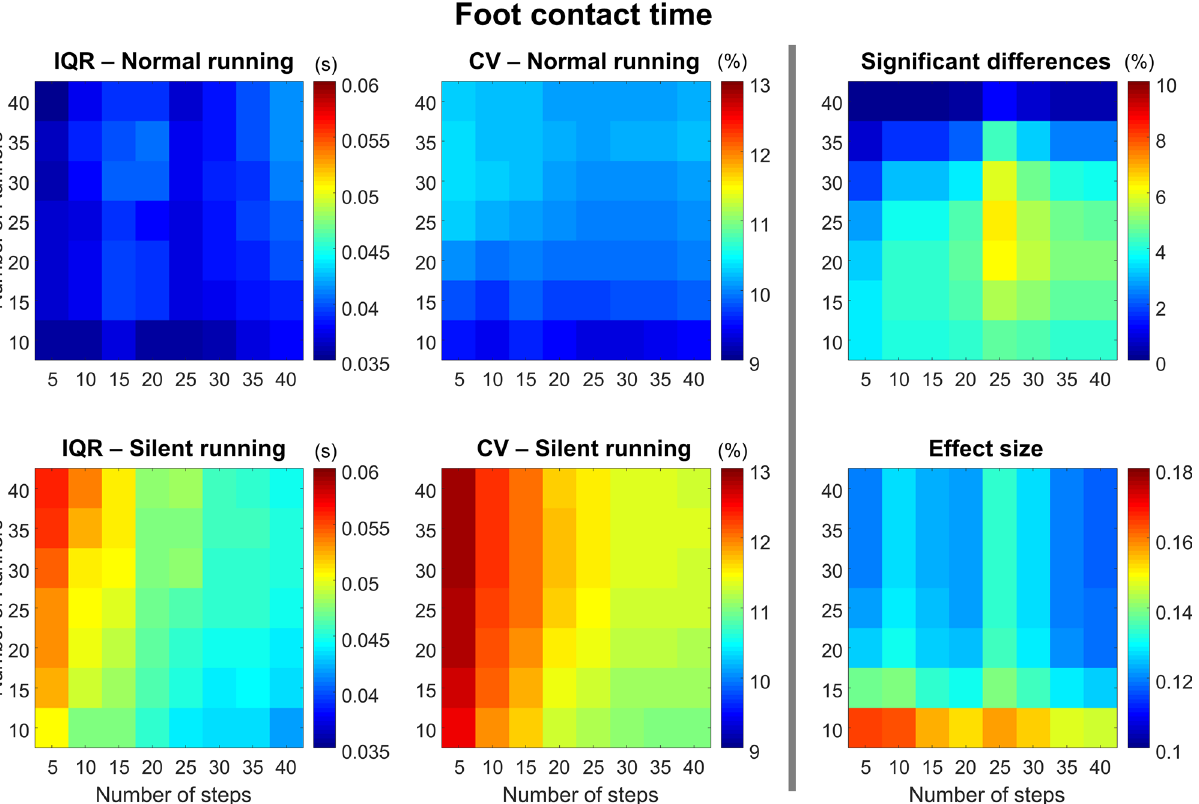
Figure 6. Colormaps demonstrating foot contact time interquartile range (IQR, left column ) and coefficient of variation (CV, central column ) from the combination of 10–40 runners versus 5–40 running steps. Data is shown from normal running ( top panels ) and silent running ( bottom panels ). Each value is an average from 100,000 paired permutations for each combination. The number of significant differences ( p < 0.05, expressed as a percentage of 100,000 comparisons, top right panel ) and their respective effect size ( bottom right panel ) illustrate the changes in statistical outcomes depending on the combination of number or runners versus number of